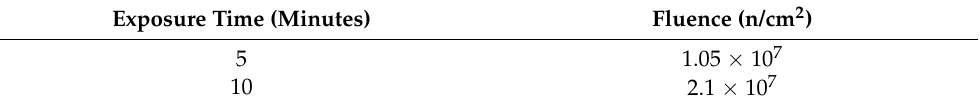
Table 5. The total fluence per sample for different exposure times (L/D = 50).